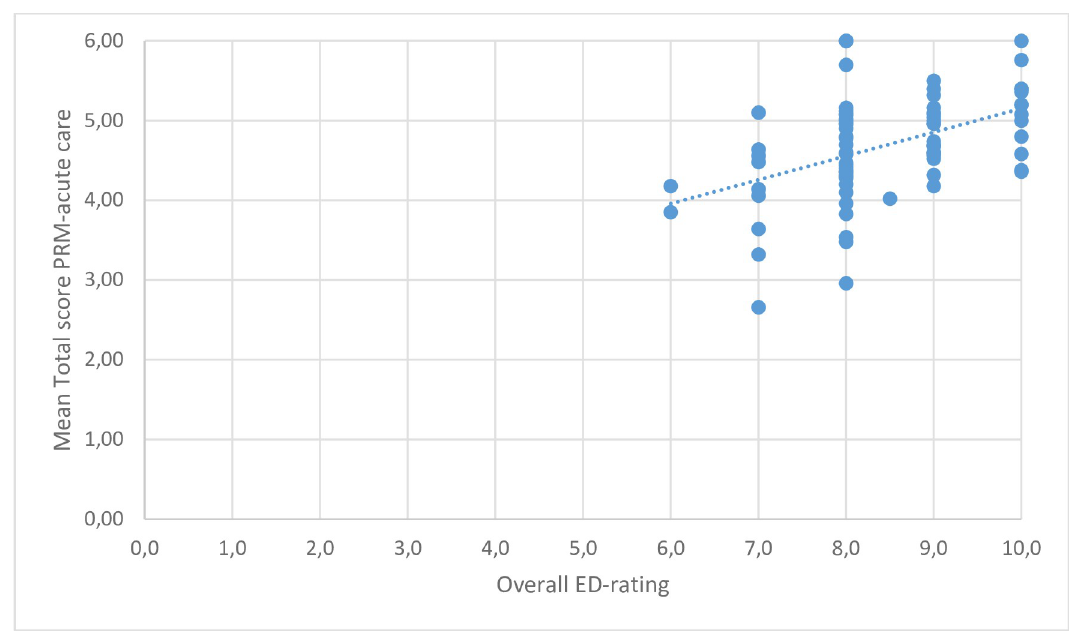
Fig 1. Correlation between total mean score and overall satisfaction in the ED.